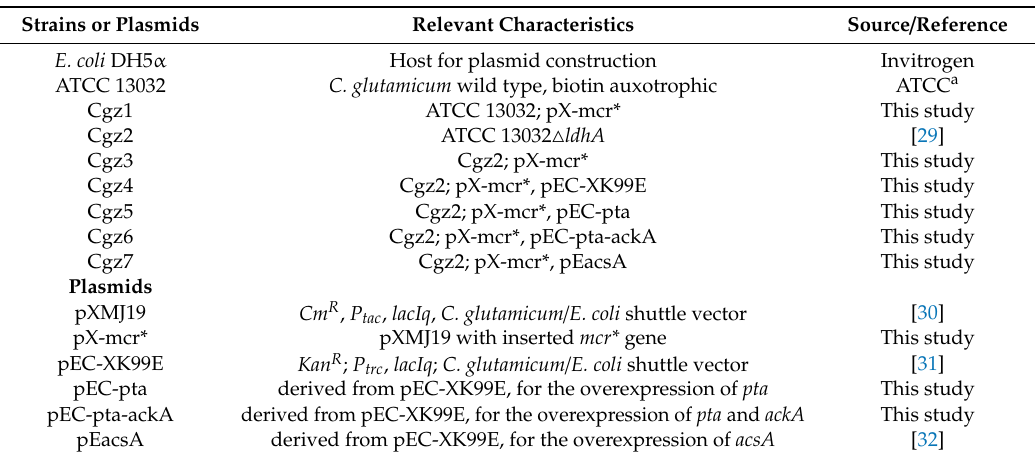
Table 1. Strains and plasmids used in this study.